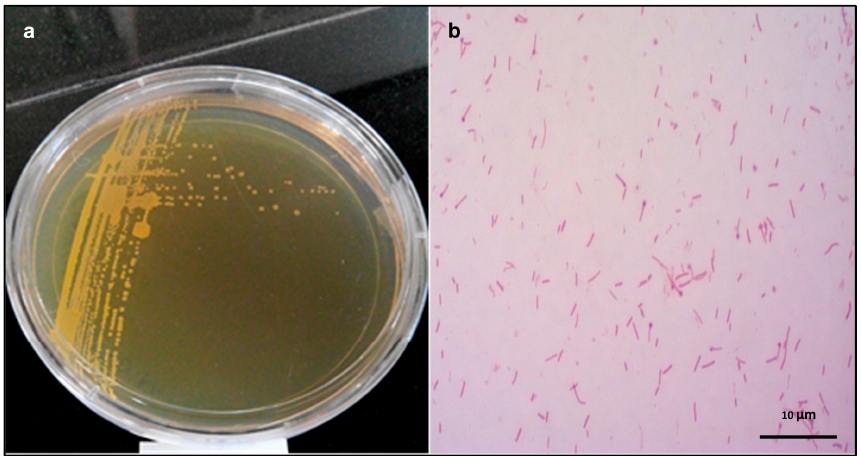
Figure 1. ( a ) Colonies of the Piscibacillus sp. C12A1 on C modified medium. ( b ) Bright field microscopy showing C12A1, gram-positive rod with oval endospores.